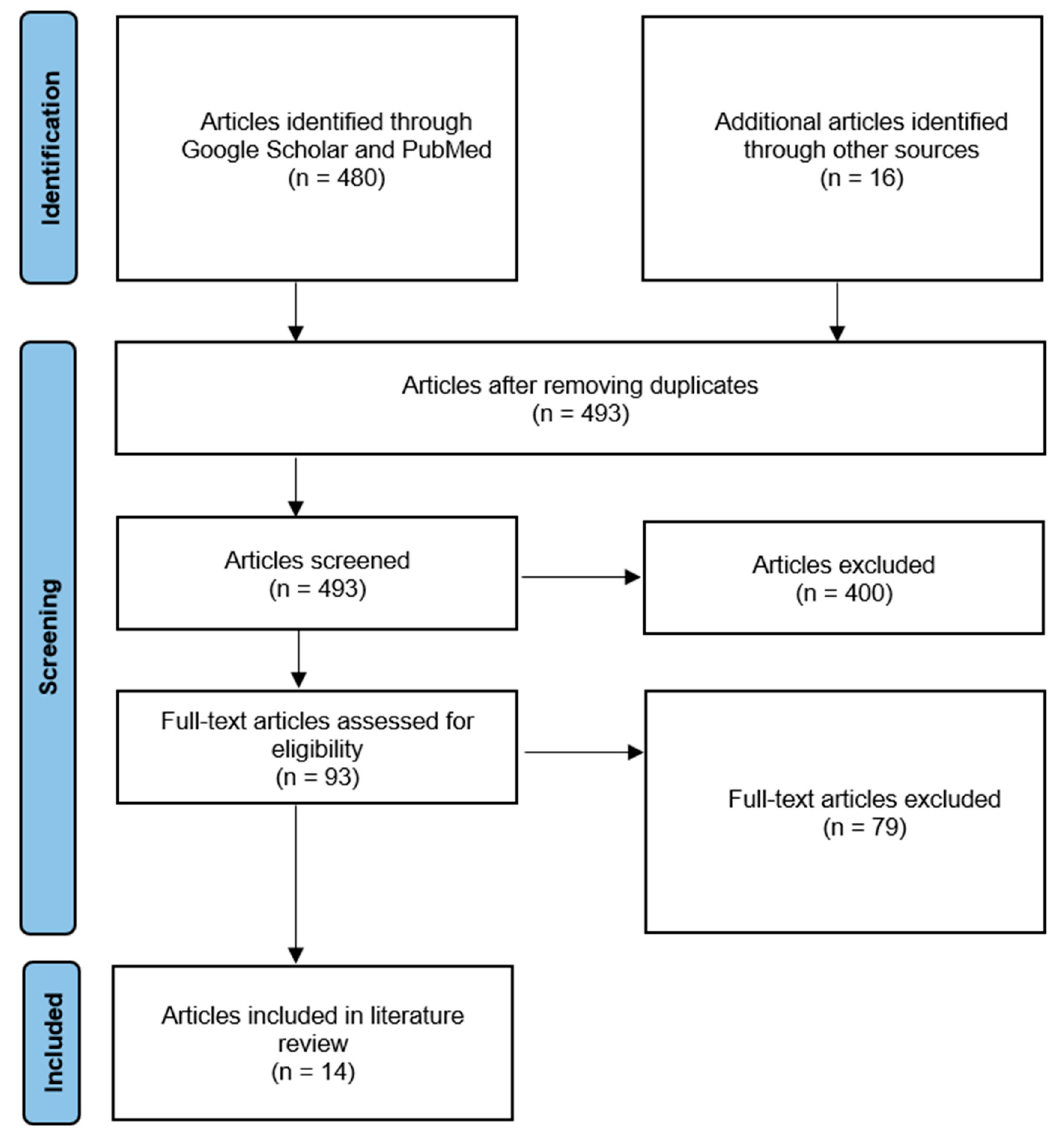
Figure 1. The figure shows a flowchart of the inclusion and exclusion criteria of the